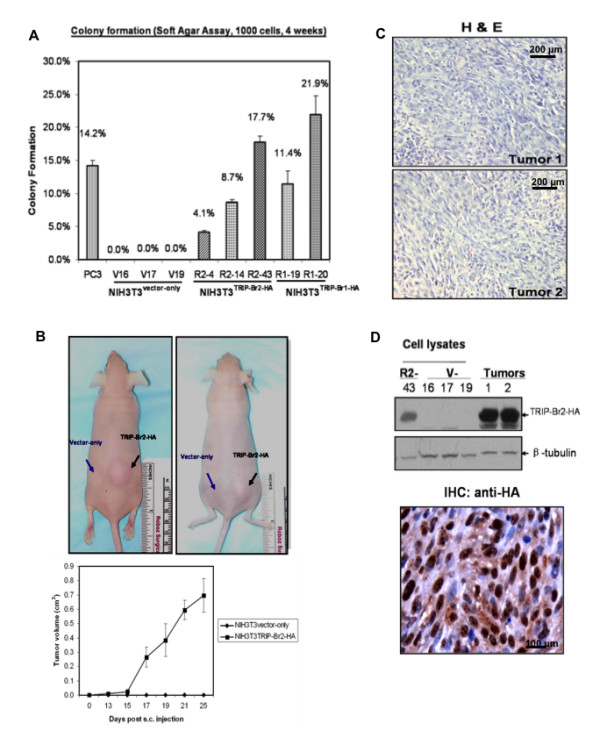
Overexpression of TRIP-Br2-HA confers anchorage-independent growth on soft agar and induces tumors in nude mice (nu/nu). (A) Anchorage-independent growth of NIH3T3vector-only, NIH3T3TRIP-Br1-HA and NIH3T3TRIP-Br2-HA was assessed by colony formation in soft agar. The error bars represent the standard deviations of three independent experiments performed in triplicates. PC3 cells were used as a positive control. V: Vector-only clones; R1: TRIP-Br1-HA-overexpressing clones; R2: TRIP-Br2-HA-overexpressing clones. (B) Upper panel: Results of a representative experiment in which NIH3T3TRIP-Br2-HA and NIH3T3vector-only fibroblasts were subcutaneously injected into the left and right flanks of nude mice, respectively. Lower panel: Average tumor ellipsoid volume over 25 days post-subcutaneous injection was calculated, and the animals were subsequently sacrificed. (C) Histological analyses of excised tumors indicated the presence of fibrosarcomas. (D) Western blot (Upper panel) and immunohistochemical analyses (Lower panel) of excised tumors showed expression of TRIP-Br2-HA. Immunopositive staining for TRIP-Br2-HA is represented by the brown color against the hematoxylin (blue) counterstain. Data was obtained from three independent experiments that were performed in triplicates.